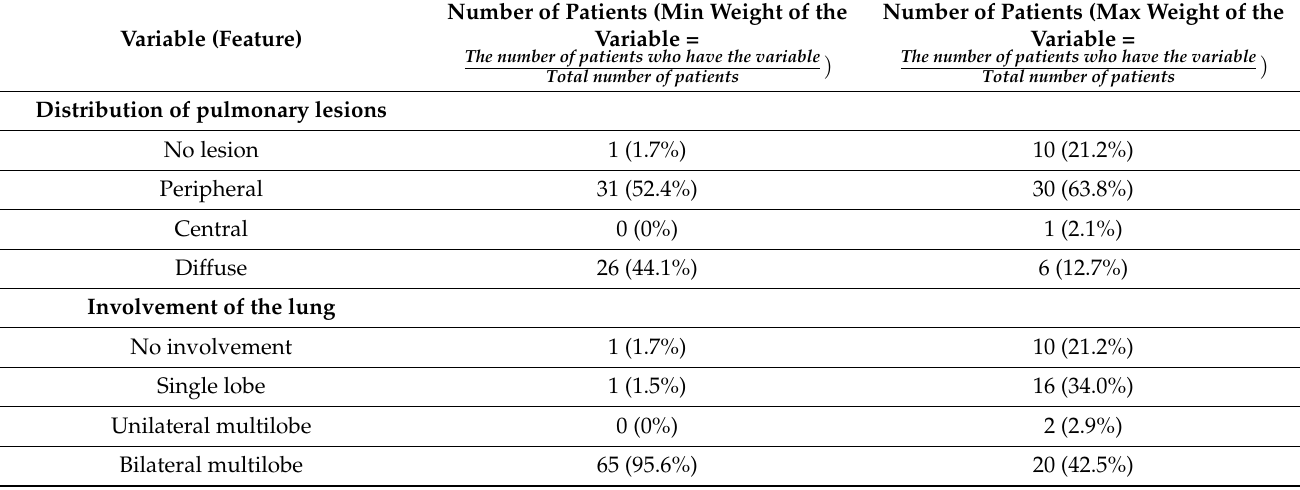
Table 2. The counting data for the medical image used in the CNN model [36]. Number of Patients (Min Weight of Variable (Feature)